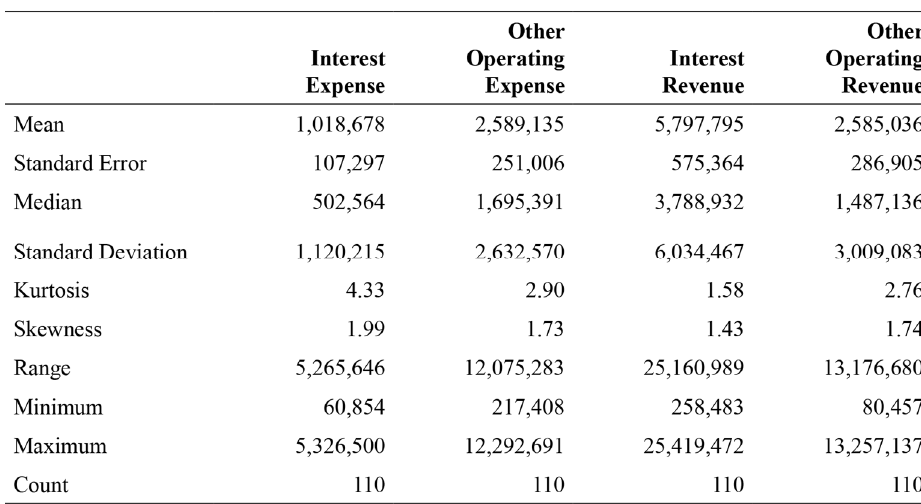
Descriptive statistics for the variables (inputs and outputs) in commercial banks in Serbia (in 000 SRB Dinars). Serbia (in 000 SRB Dinars).